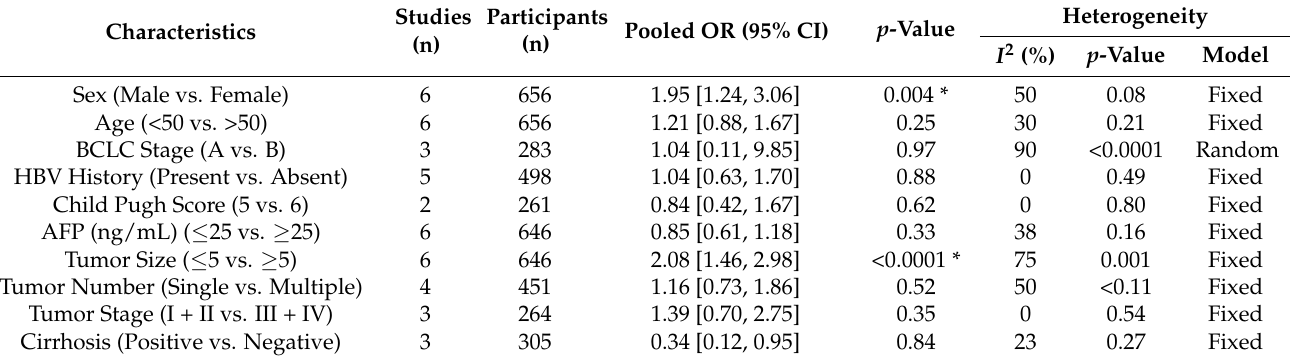
Table 3. Clinicopathological characteristics and pooled ORs associated with PDL-1